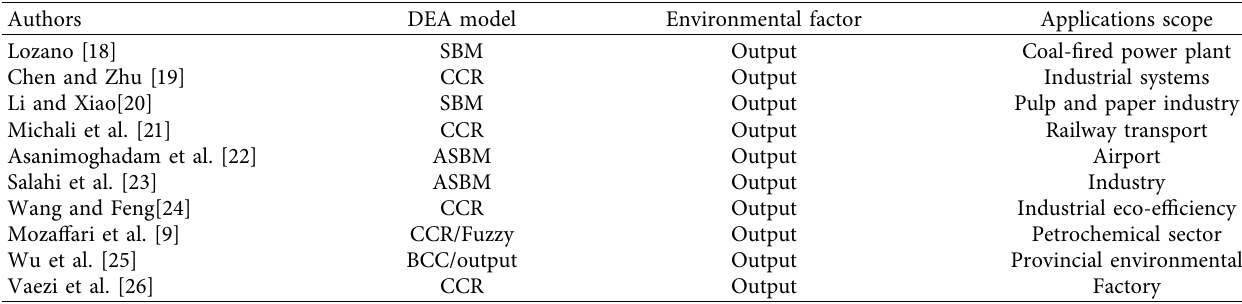
Table 2: Some advances of environmental factor applications in NDEA.